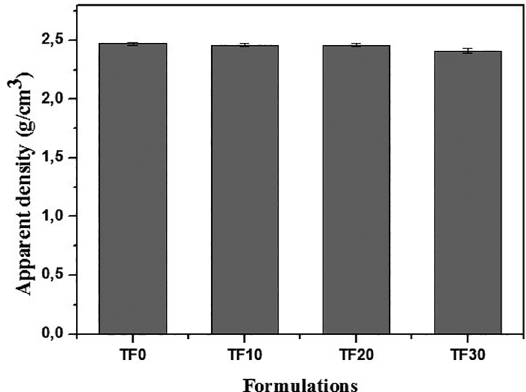
Figure 5. Apparent density of the fired aluminous porcelain pieces.